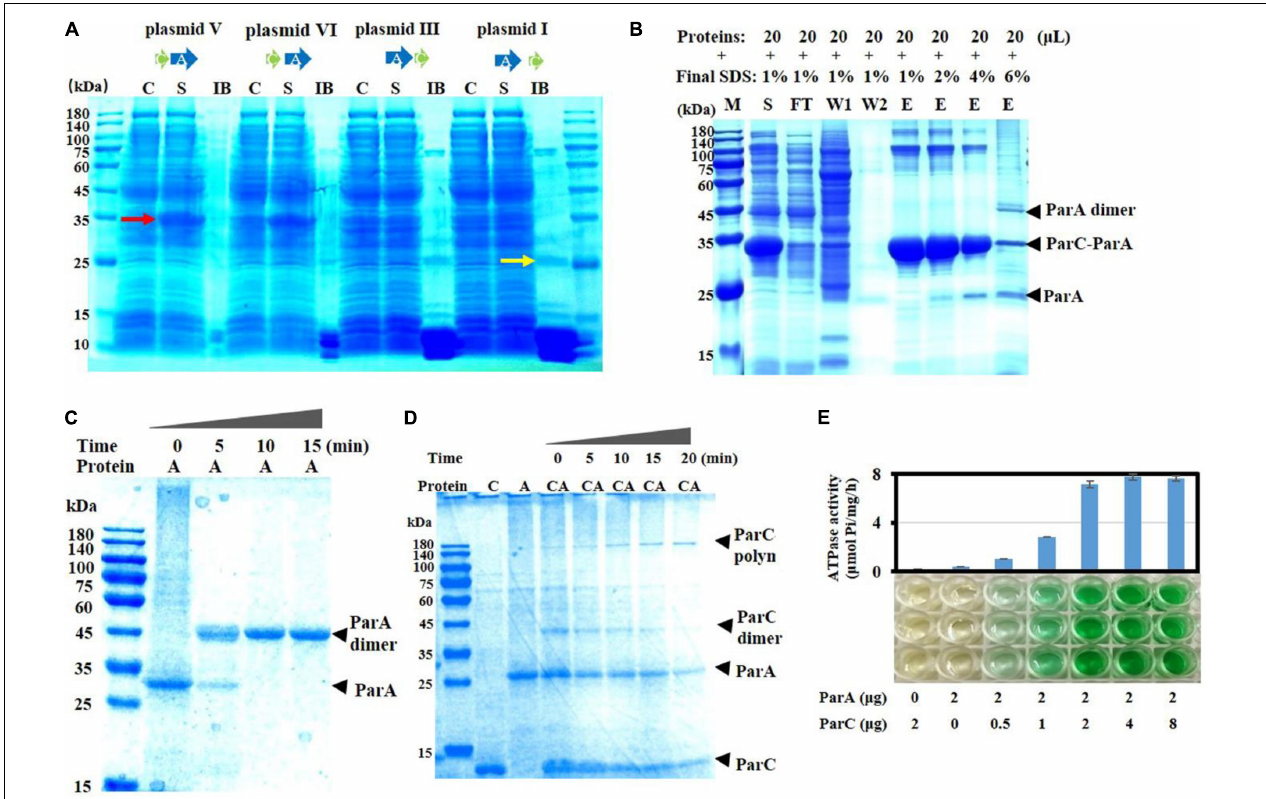
FIGURE 2 | Expression and activities of ParC and ParA proteins. (A) The two genes were linked into the expression plasmid pET-15b according to the arrangement sketched in Figure 1C . The recombinant plasmids were transformed into E. coli BL21(DE3) and expressed by IPTG induction. After harvesting, cells were washed, lysed, and centrifuged. The supernatant (S) and inclusion body (IB) were analyzed by SDS-PAGE. Non-induced cultures were used as control (C). To aid protein dissolution for electrophoresis, IB was homogenized using a tissue grinder and treated with 6 M guanidine hydrochloride (GuCl). The induced soluble proteins (35 kDa) were pointed by a red arrow, while the insoluble proteins with the ParA size was pointed by a yellow arrow. (B) Co-expression of the parC (fused with a His-tag) and parA genes in E. coli . The parC and parA genes were constructed in pET15b, which was electrotransformed into E. coli cells for expression. The expressed His-tagged ParC proteins were purified using Ni-NTA agarose according to the standard protocol (Qiagen, Valencia, CA, United States). The purified proteins were treated with gradient SDS concentrations and analyzed by SDS-PAGE. M, marker; C, control; S, supernatant; IB, inclusion body; FT, flow though; W, washing; E, elution. (C) ParA aggregation analysis. ParA monomer was incubated at 32 ◦ C for the indicated times (0, 5, 10, and 15 min), and the aggregation was mixed with 0.1% SDS and detected by native-page electrophoresis. (D) Interactions between ParA and ParC in binding buffer containing 3 mM ATP, incubated at 32 ◦ C. The mixture was sampled at intervals of 0, 5, 10, 15, and 20 min, and detected by electrophoresis. (E) ATPase activity assay with ParC and ParA proteins. ATPase activity was measured by detecting the release of Pi at 32 ◦ C. Data shown are averages of three repeats. Error bars refer to the